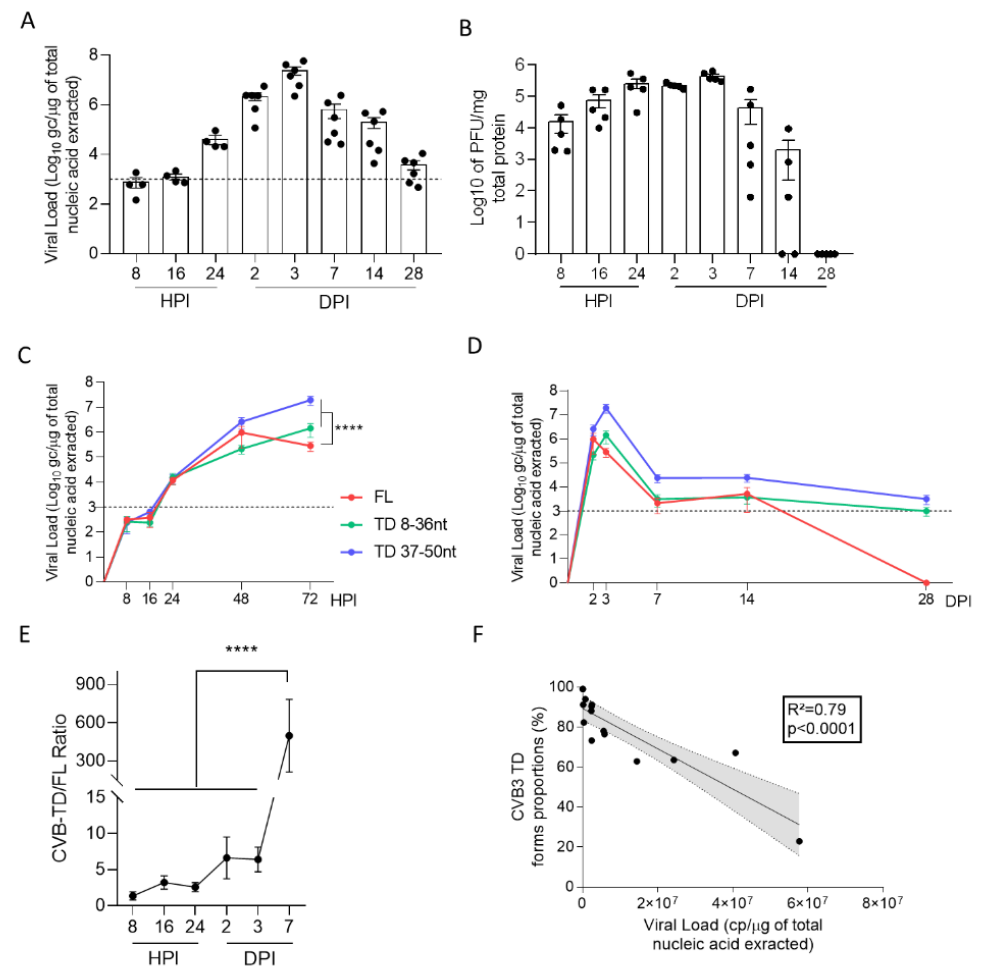
Figure 1. Dynamics of emergence and replication activities of 5′ terminally deleted CVB RNA forms in the pancreas. ( A ) Viral loads were quantified in the pancreas of CVB3/28-infected DBA/2J mice by classic RT-qPCR assay ( n = 4 to 6, each dot represents one mouse). The dotted line represents the significance threshold of 10 3 genome copy (gc)/microgram of total nucleic acid extracted. ( B ) Viral titers were measured in the pancreases of CVB3/28-infected DBA/2J mice by classic plaque-forming unit assay (PFU) ( n = 5, each dot represents one mouse). ( C , D ) The respective viral loads of EV-B full- length (FL) and 5′TD were measured using a RACE -PCR method associated with micro-elec- trophoresis (Agilent ® ) in the pancreases of CVB3/28-infected mice ( n = 4 to 8). ( A – D ) Data represent mean +/− standard error of the mean (SEM). ( E ) 5′ TD/FL ratio in the pancreases of CVB3/28 infected mice from 8 HPI to 7 DPI. Multiple comparison test of the 5′ TD/FL ratio. ****: p < 0.0001, multiple comparisons test. ( F ) Linear regression curves and Spearman R coefficients of correlation between viral loads and 5′ TD EV-B proportions (2 to 7 DPI; n = 15, each dot represents one mouse). DPI: days post infection. HPI: hours post infection. CVB: coxsackievirus. TD: 5′ terminally deleted. FL: full-length. nt: nucleotides. 3.2. Viral Characteristics of CVB-TD RNA Forms Detected in Pancreases of DBA/2J Mouse To further evaluate the RNA genomic replication capacities of CVB populations in the mouse pancreas, we determined the (+)/( − ) viral RNA and the single/double-strand (ss/ds) viral RNA ratio (Table 1). High (+)/( − ) and ss/ds RNA ratios were evidenced at 3 DPI, indicating high levels of viral genomic replication (Table 1). By contrast, after 14 DPI, a decrease in (+)/( − ) and ss/ds RNA ratio indicated impaired viral genomic replication (Ta- ble 1). Moreover, viral progeny was high at 3 DPI, low at 14 DPI and undetectable at 28 DPI (Figure 2B). We showed that CVB populations at 3 DPI were encapsidated (73%) (+) ssRNA forms, whereas at 14 and 28 DPI, CVB populations were non-encapsidated (9.2% and 2%, respectively) ( − ) or dsRNA forms (Table 1). Overall, we evidenced high levels of